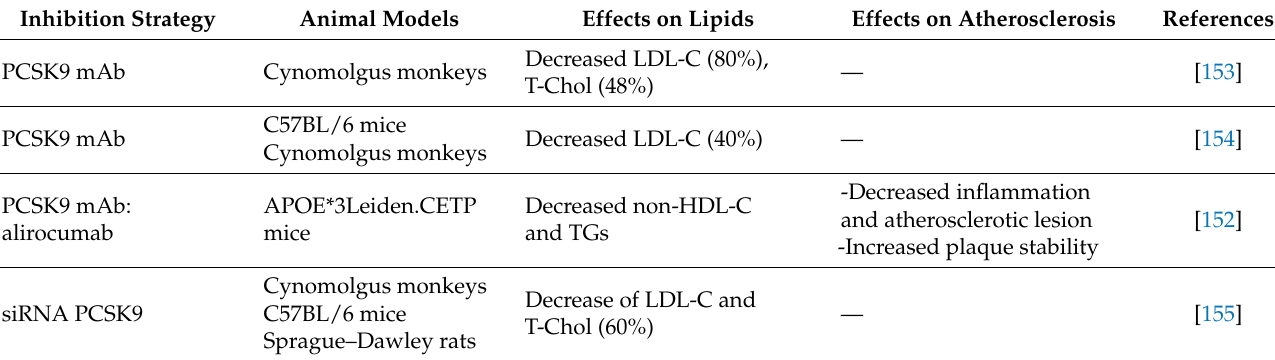
Table 4. Pre-clinical and clinical trials studying PCSK9 inhibitors in the context of hypercholesterolemia. Inhibition Strategy Animal Models Effects on